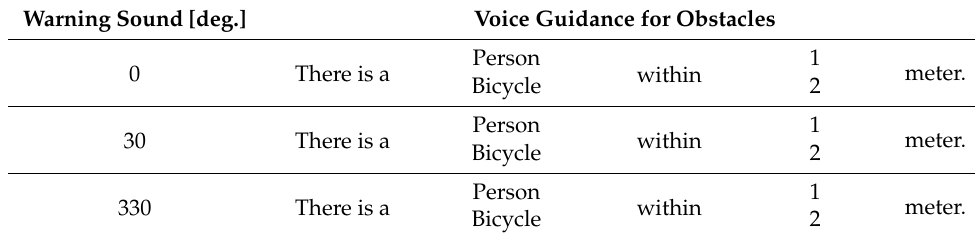
Table 10. Voice guidance for obstacle avoidance. Warning Sound [deg.] Voice Guidance for Obstacles